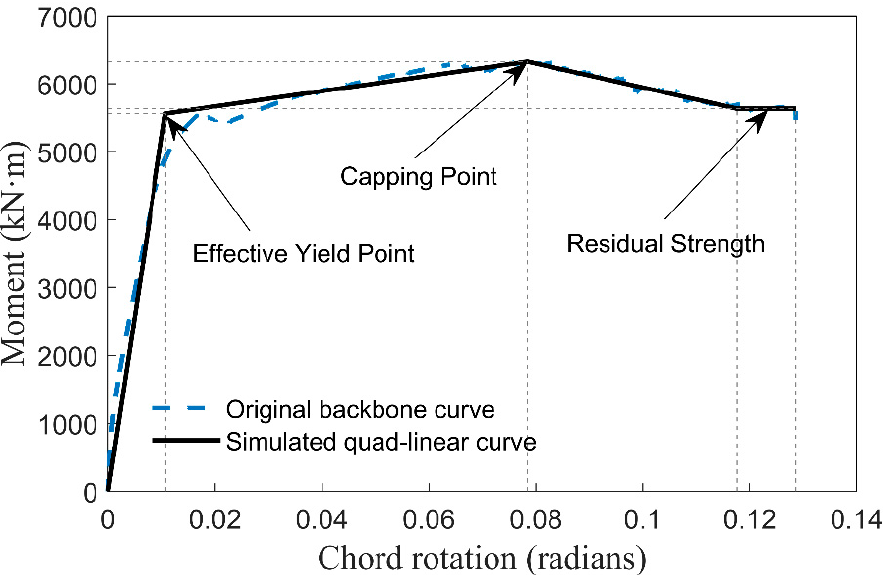
Figure 5. Schematic illustration of simulating the backbone curve with the quad-linear